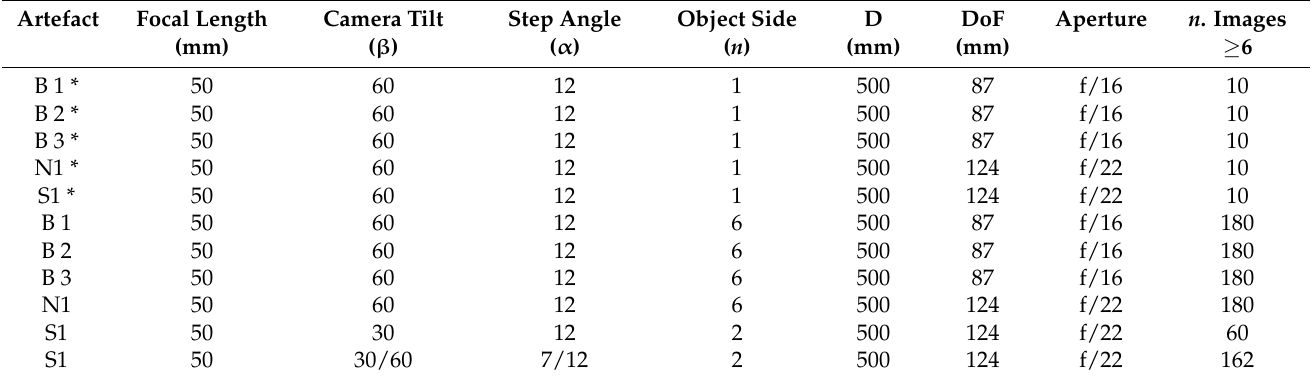
Table 2. Setting values for the Camera (Canon EOS RP) depending on the object dimension and maximum DoF. Artefact Focal Length Camera Tilt Step Angle Object Side DoF Aperture n .